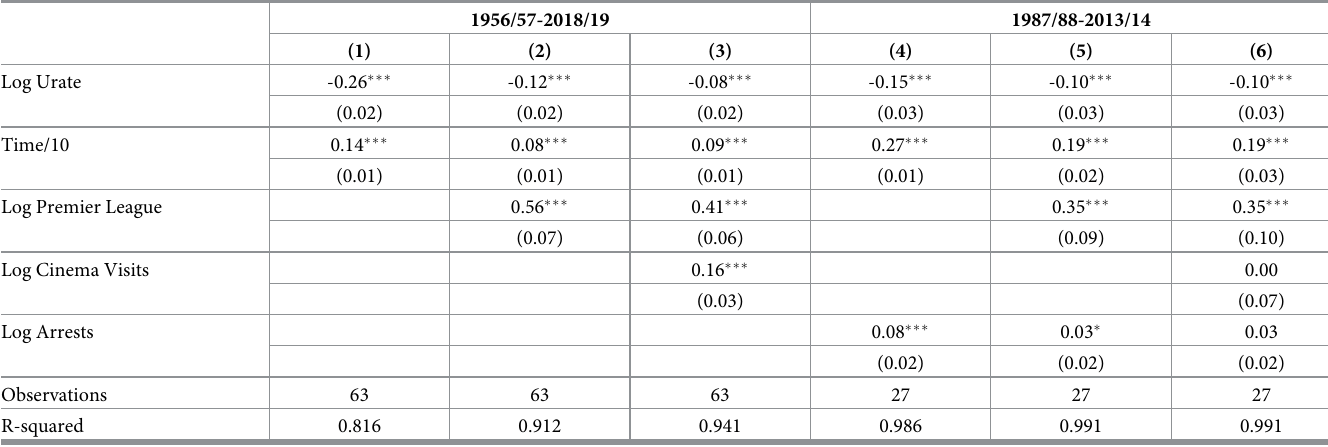
Table 5. Parameter estimates stadium attendance; second stage—seasonal